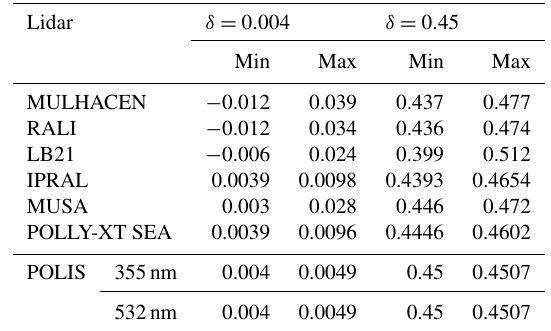
Table 6. Minima and maxima of the simulated δ for the EARLINET lidar systems at δ r = 0004 and δ r = 045. (cid:49)δ is the minimum and maximum